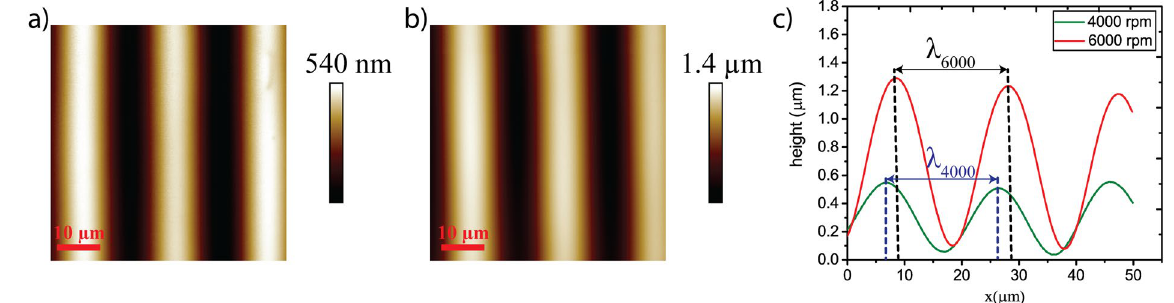
Figure 3. AFM measurements (scan area of 50 µ m × 50 µ m) at two different target spin speeds and the relative average height profiles. At 4000 rpm ( a ) and 6000 rpm ( b ) AFM images show well defined wrinkled topographies. The average height profiles at 4000 rpm (green) and at 6000 rpm (red) corresponding to the AFM images are shown in ( c ) providing the height and the wavelengths of the grooves at 4000 rpm ( λ 4000 ) and at 6000 rpm ( λ 6000 ).